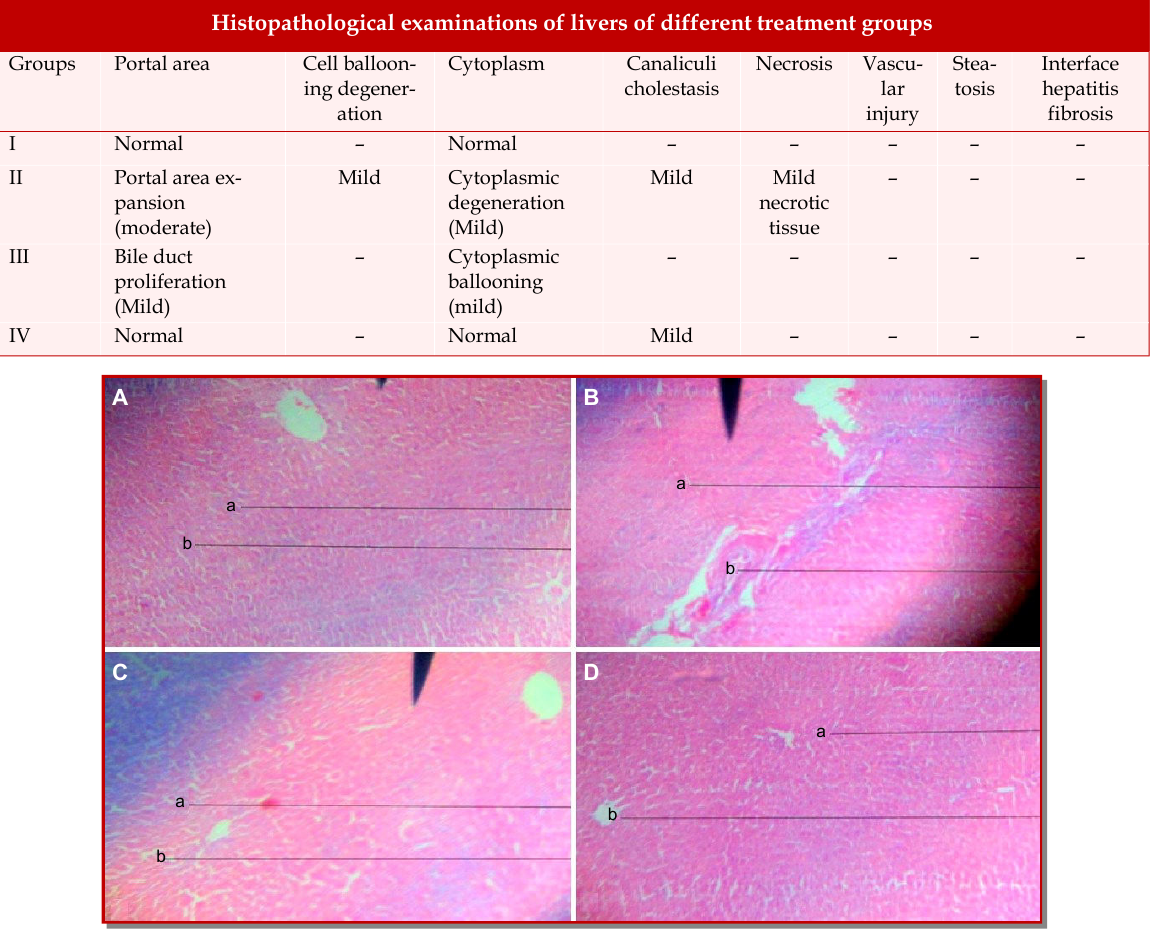
Histopathological examinations of livers of different treatment groups